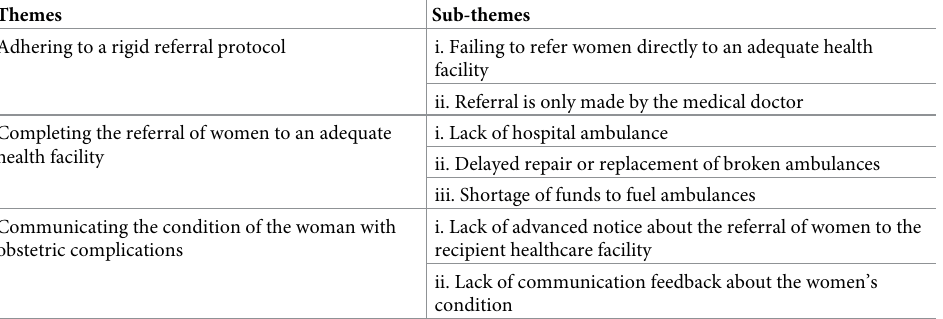
Table 2. Themes and subthemes from healthcare providers experience in implementing referral